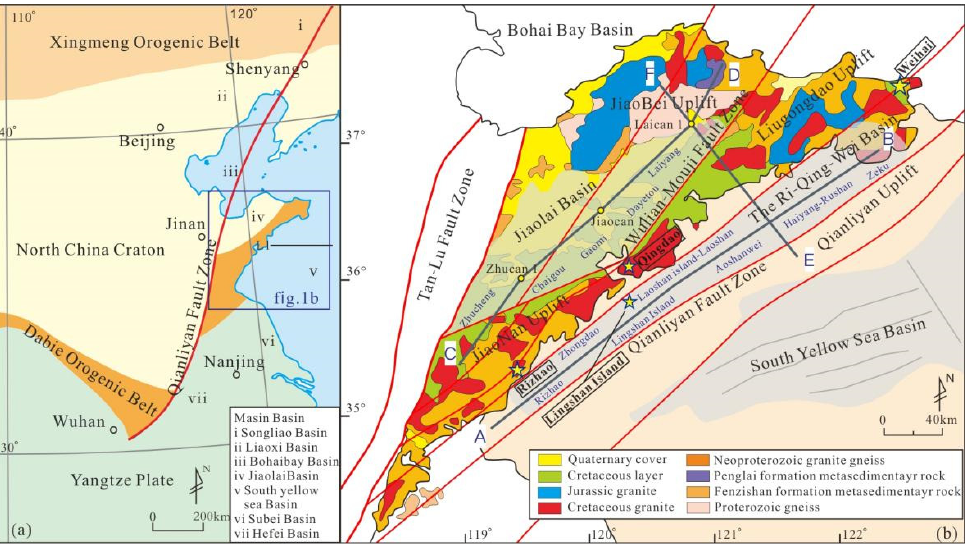
Figure 1. Geological sketch of the study area: ( a ) tectonic outline map of eastern China (modified from [3]); ( b ) tectonic outline map of eastern Shandong and adjacent areas (modified from [4]). The Jiaolai basin is northwest of the Ri-Qing-Wei basin, between the Jiaobei and Jiaonan-Liugongdao uplifts, a Mesozoic fault basin. It comprises three depressions: Zhucheng in the southwest, Gaomi in the center, and Laiyang in the northeast. The thickness of dark mudstone is 200, 200, and 50 m, respectively [5]. The oil and gas from the wells in the Shuinan formation of the Laiyang group in the Laiyang depression have the best hydrocarbon fluorescence. The oil and gas deposits in the Laiyang formation reflect the different characteristics in the sedimentary phases of the basin formation